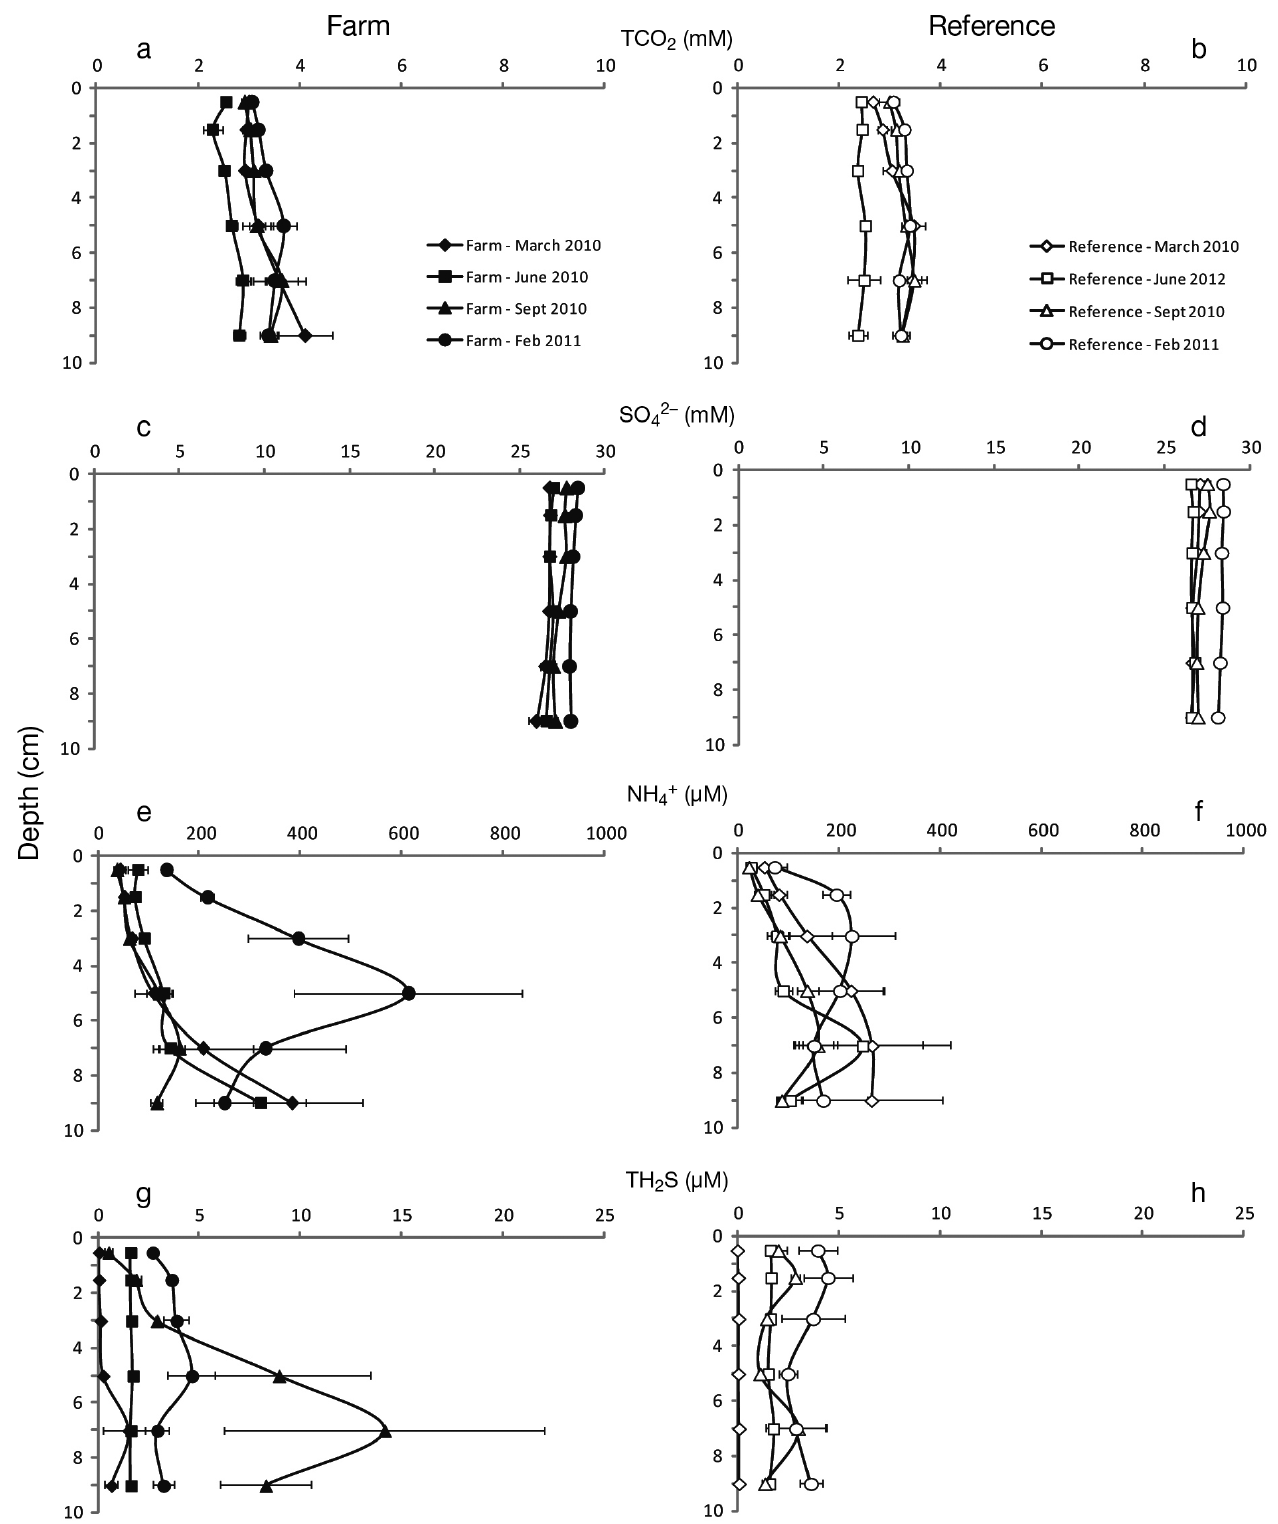
Fig. 4. Average concentration of pore water solutes in sediments from the farming (solid symbols; left column) and reference (open symbols; right column) locations at 3 different time points over the production cycle: (a,b) total CO 2 (TCO 2 ), (c,d) SO 42− , (e,f) NH 4+ and (g,h) total H 2 S (TH 2 S). Error bars represent SE (n =